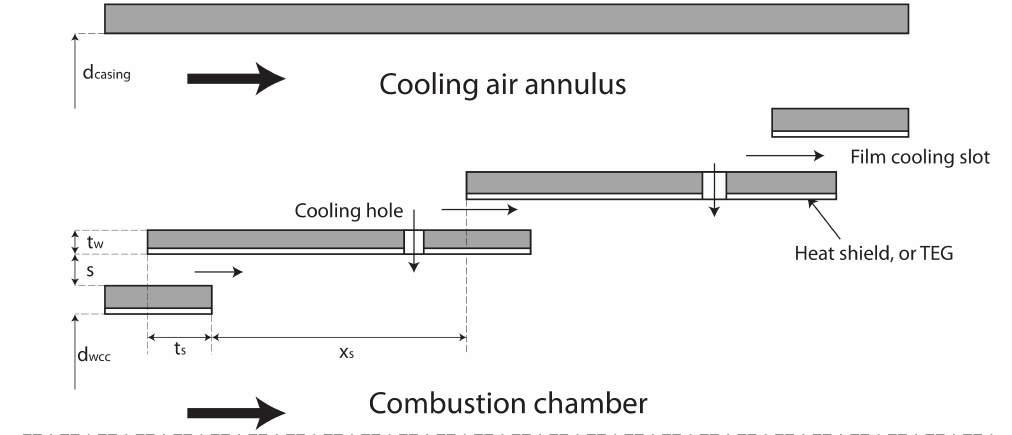
Figure 5. Sketch of the combustion chamber